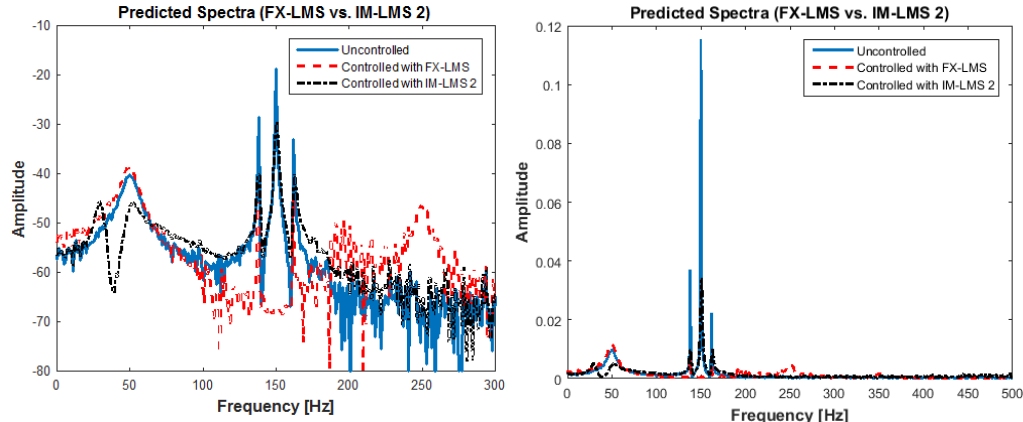
Figure 9. Predicted spectra for an amplitude-modulated (AM) signal with LMS and internal model LMS 2 methods.